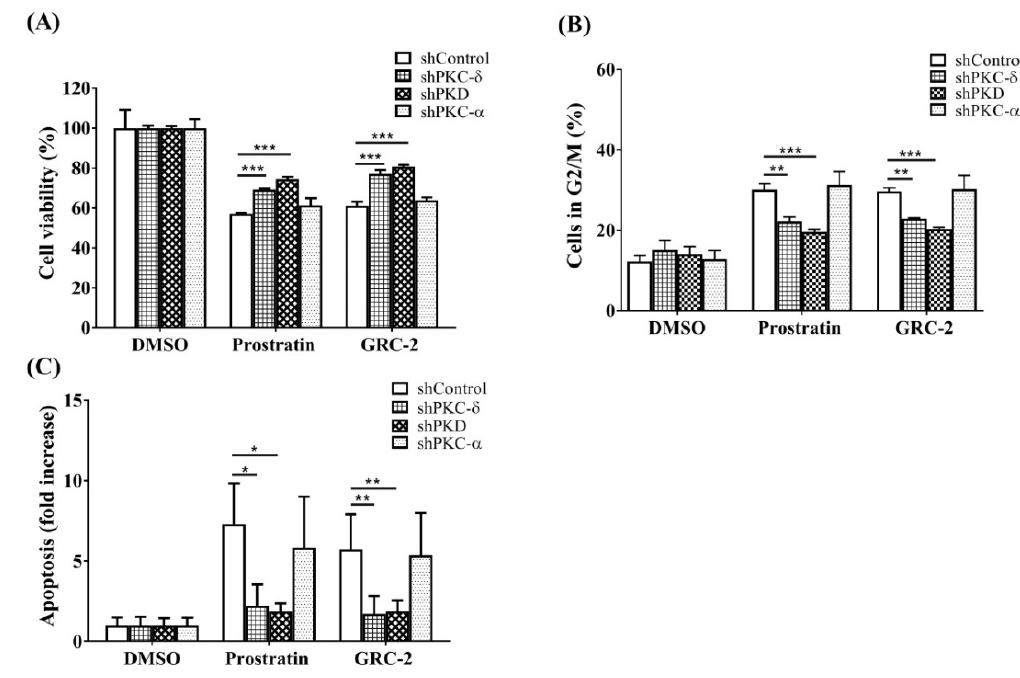
Figure 3. Prostratin and GRC-2 activates PKC isoforms and PKD in A549 cells. ( A ) A549 cells